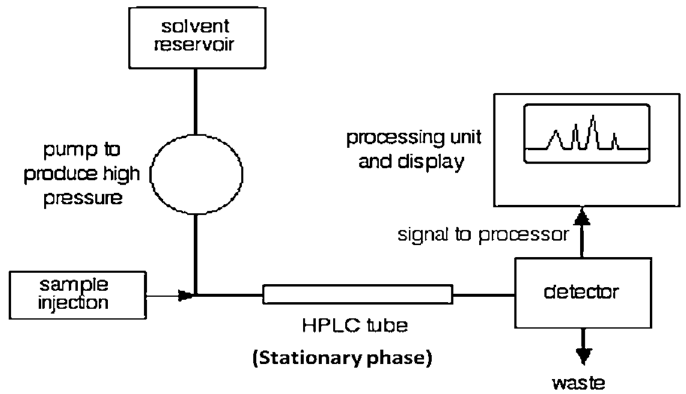
Figure 5. HPLC process scheme.